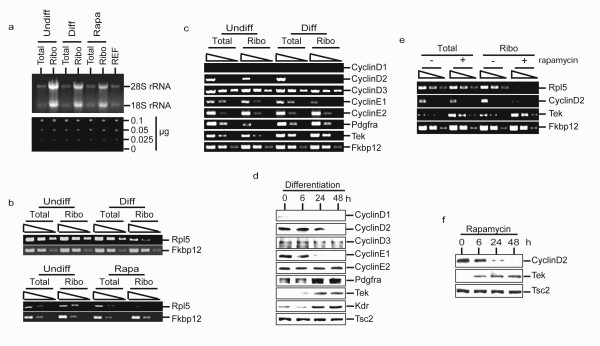
Translational control during endothelial differentiation and rapamycin treatment. a) Preparation of total RNA and ribosome-enriched RNA. RoSH2 cells, RoSH2 induced to differentiate by plating on matrigel for 48 hours and RoSH2 cells treated with 50 ηM rapamycin for 48 hours were harvested. Total and ribosome-enriched RNAs were quantitated by absorbance at 260 nm. 2 μg of RNA from each of the two cellular fractions were separated on a 1.0% agarose gel, stained with ethidium bromide and visualized under UV illumination. Top panel Representative RNA samples from total and ribosome-enriched RNAs prepared from undifferentiated (Undiff), differentiated (Diff) and rapamycin-treated (Rapa) RoSH2 cells are shown. Bottom panel For each sample, 1 μl of serially diluted RNA sample mixed with 1 μl of 0.5 ηg/μl ethidium bromide was visualized under UV illumination to verify RNA loading in each lane; RNA was isolated from total cellular extract (total) and ribosome-enriched subcellular fraction (ribo) prepared from RoSH2 cells before and 48 hours after induction of endothelial differentiation by plating matrigel-coated plates; b) Distribution of rpL5 mRNA in total and ribosome-enriched RNAs before and after differentiation. RT-PCR using oligo-dT-primed cDNA, and Rpl5 and Fkbp12 specific primers was performed on 10 fold serial dilution i.e. 1×, 10× and 100× of RNAs.; c) RT-PCR analysis of transcript abundance in RoSH2 cells before and after differentiation. RoSH2 cells were induced to undergo endothelial differentiation by plating on matrigel. Total and ribosome-enriched RNA were purified at 0 and 48 hours and analyzed by RT-PCR for transcript abundance of G1 cyclins and endothelial receptors; d) Western blot analysis. RoSH2 cells were induced to undergo endothelial differentiation by plating on matrigel and at 0, 6, 24 and 48 hours, cell lysates were prepared and assayed by western blot analysis. Tsc2 protein was used as an internal control for loading between lanes and between blots; e) Effect of rapamycin on Rpl5, cyclinD2 and Tek transcript abundance in total and ribosome-enriched RNA. Total and ribosome-enriched RNA were isolated from RoSH2 cells treated for 0 and 48 hours with 50 ηM rapamycin treatment and analyzed by RT-PCR; f) Western blot analysis. Cell lysates from rapamycin-treated RoSH2 cells at 0, 6, 24 and 48 hours were assayed by western blot analysis for cyclinD2 and Tek. Tsc2 protein was used as an internal control for loading between lanes and between blots.